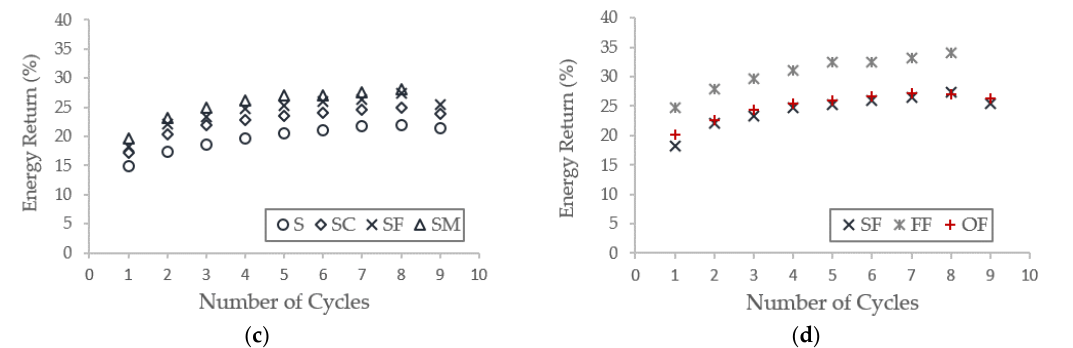
Figure 2. In each consecutive cycle: ( a ) Energy dissipation for the S carpet combined with different types of ceramic sand; ( b ) Energy dissipation for the F ceramic sand and alternating carpets; ( c ) Energy return for the S carpet combined with different types of ceramic sand; ( d ) Energy return for the F ceramic sand and alternating carpets.